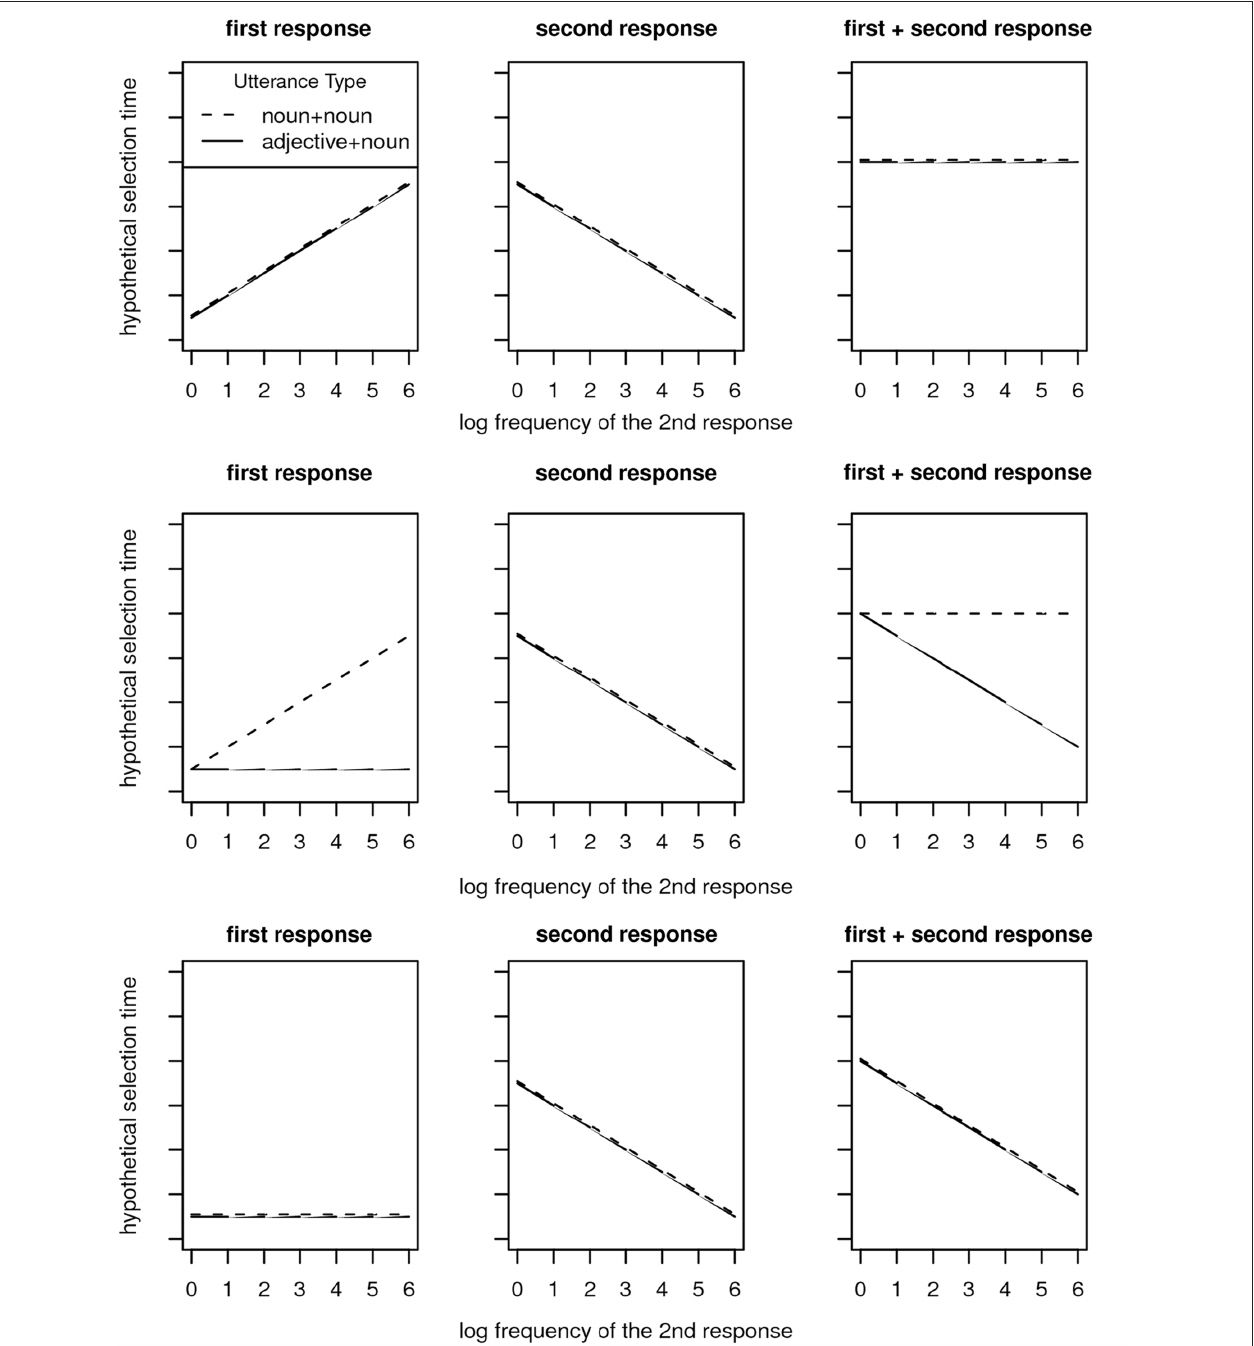
Figure 1| Predictions of the grammatically unconstrained Competitive (top row), grammatically constrained competitive (middle row), and Non-Competitive (bottom row) hypotheses of lexical selection concerning the hypothetical lexical selection times ( y -axis) for the first response